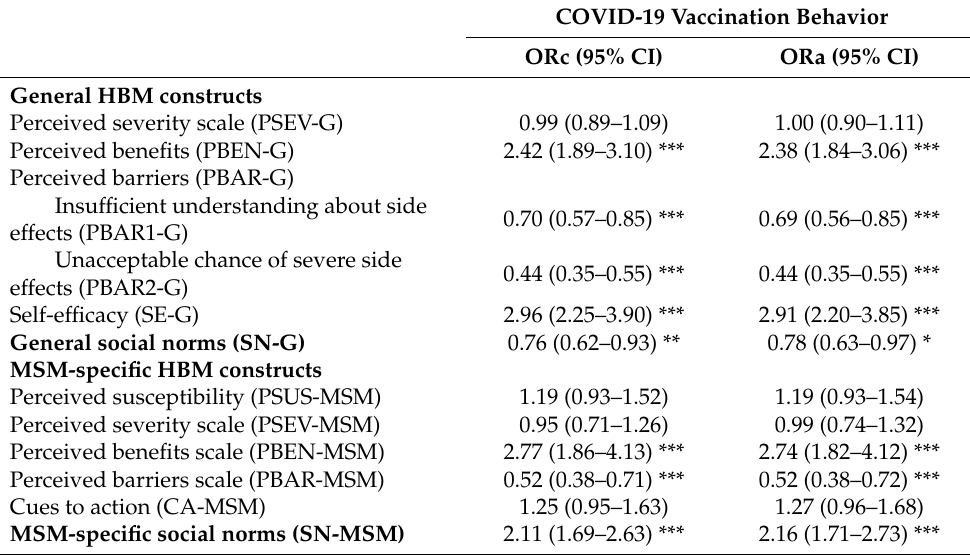
Table 4. Univariate and adjusted logistic regression analysis testing the associations between